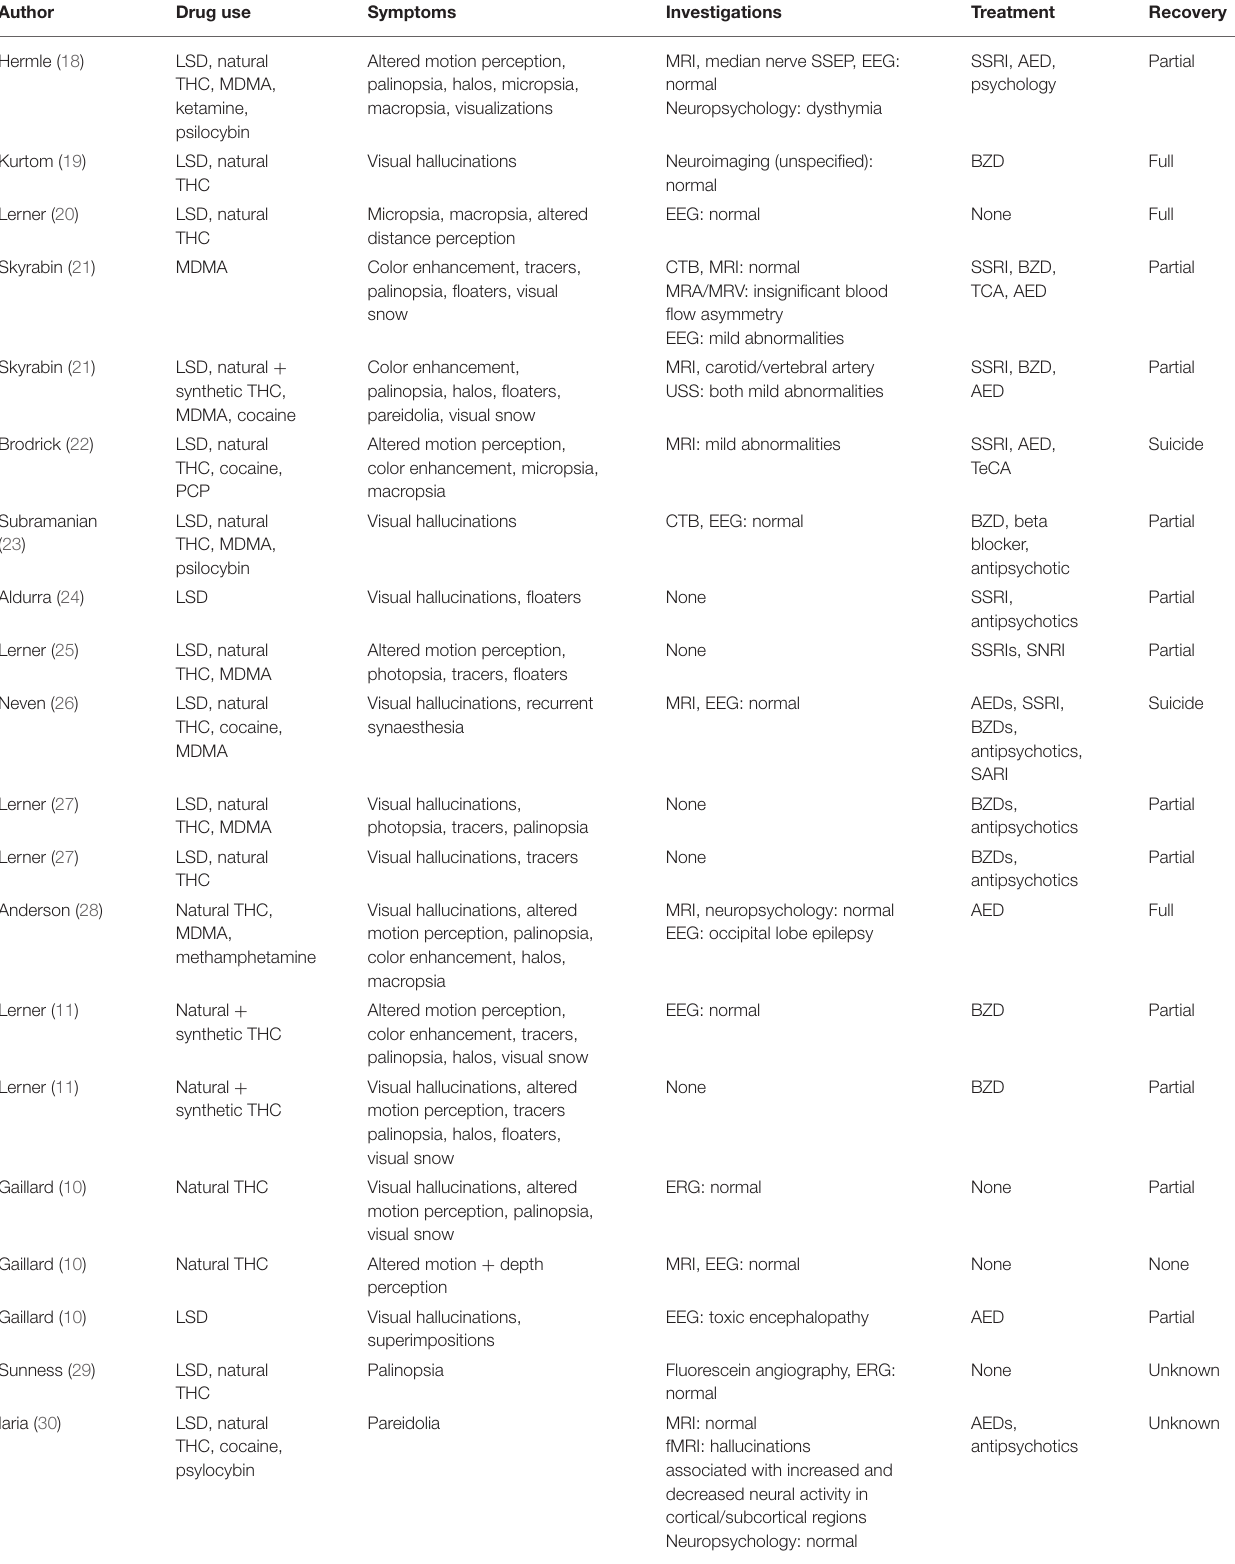
TABLE 5 | Literature review of clinical features, investigations, management and outcome of HPPD case reports ( n =